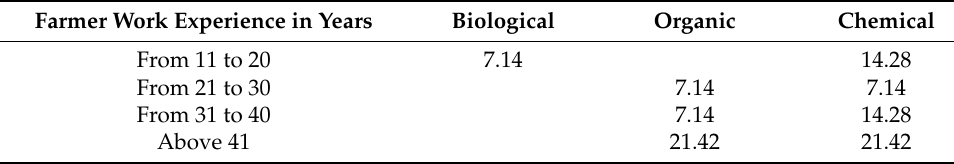
Table 2. Distribution of farmer work experience in agriculture and type of pesticide applied (values in